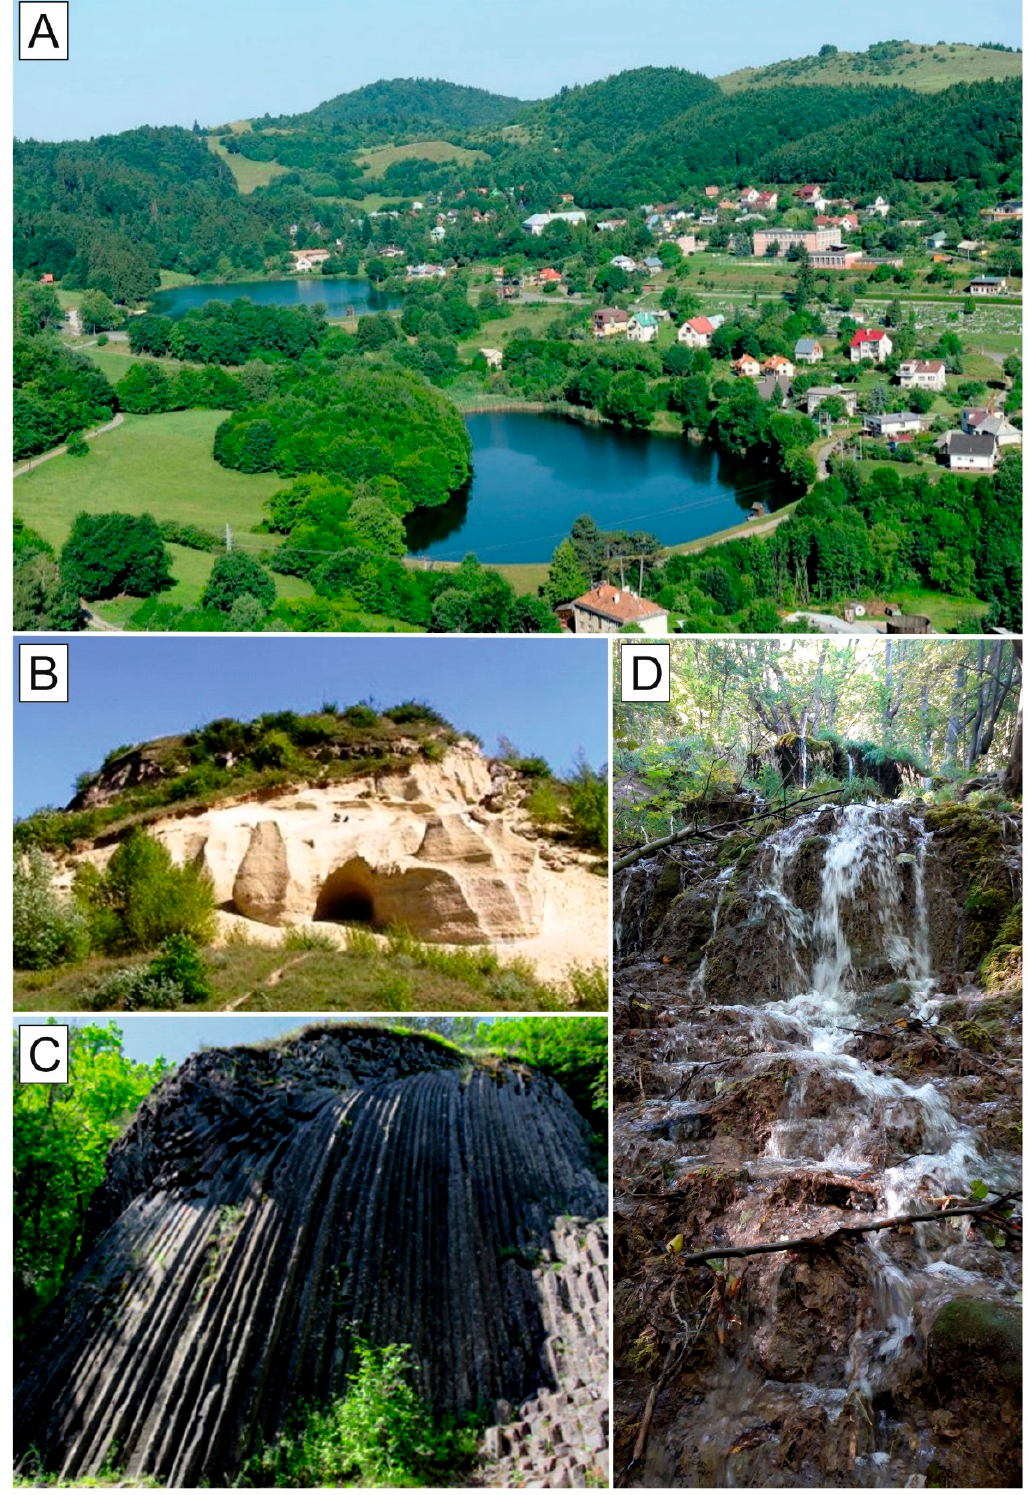
Figure 4. Examples of geoheritage sites located in Slovak geoparks. ( A ) Tajchy—artificial water reservoirs built to provide energy for mining (Banská Štiavnica Geopark); ( B ) Sandberg sand pit (Malé Karpaty Geopark); ( C ) stone waterfall (Šomoška site) (Novohrad-Nógrád Geopark); ( D ) Moštenické travertíny (travertines)—formation of slope calcareous tufa cascades (Banská Bystrica Geopark). Source: authors.